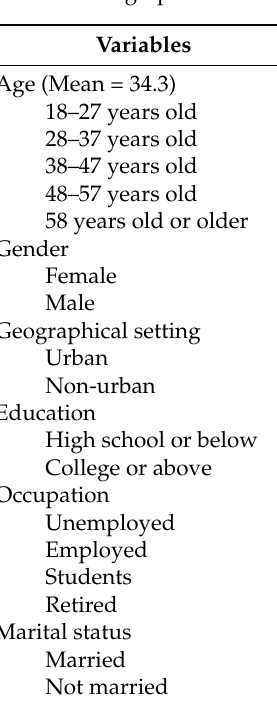
Table 1. Demographic information (N = 10,047).